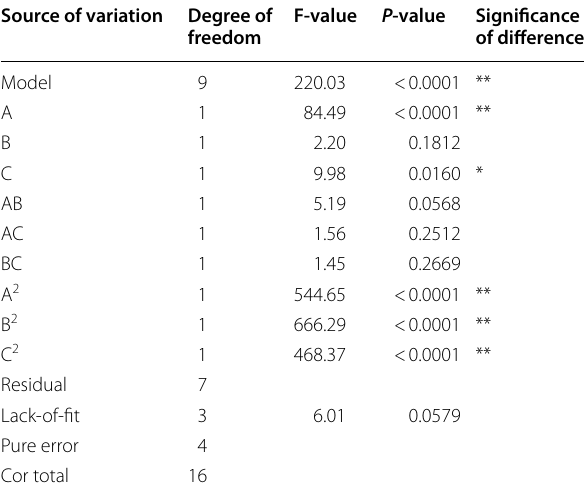
Table 6 Analysis of variance for the regression model